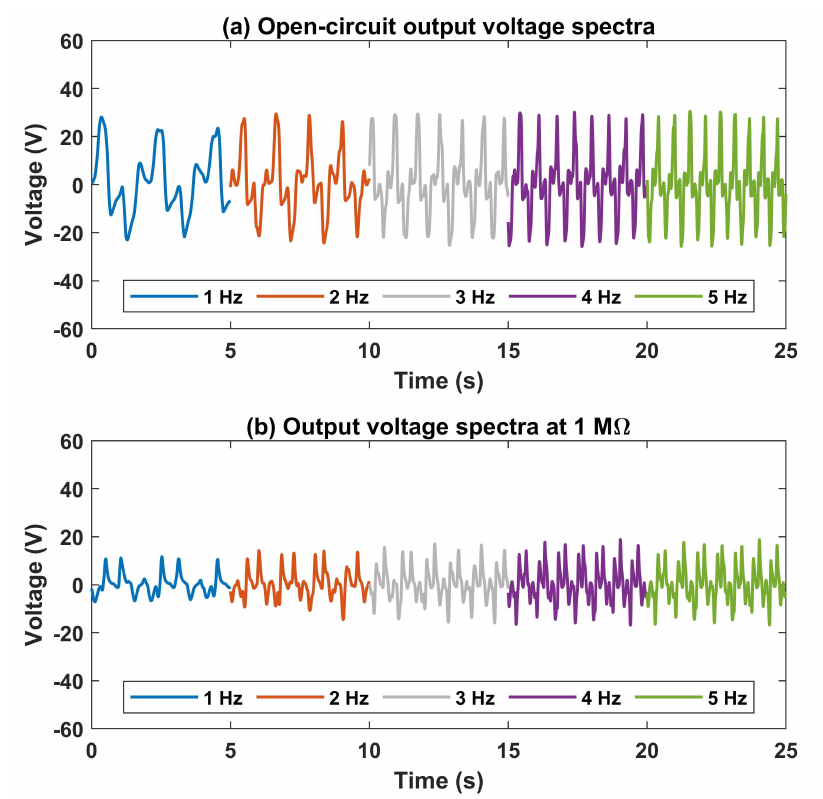
Figure 11. MPVEH response to different excitation frequencies. ( a ) Open-circuit voltage spectra and ( b ) output voltage spectra with resistance of 1 M Ω